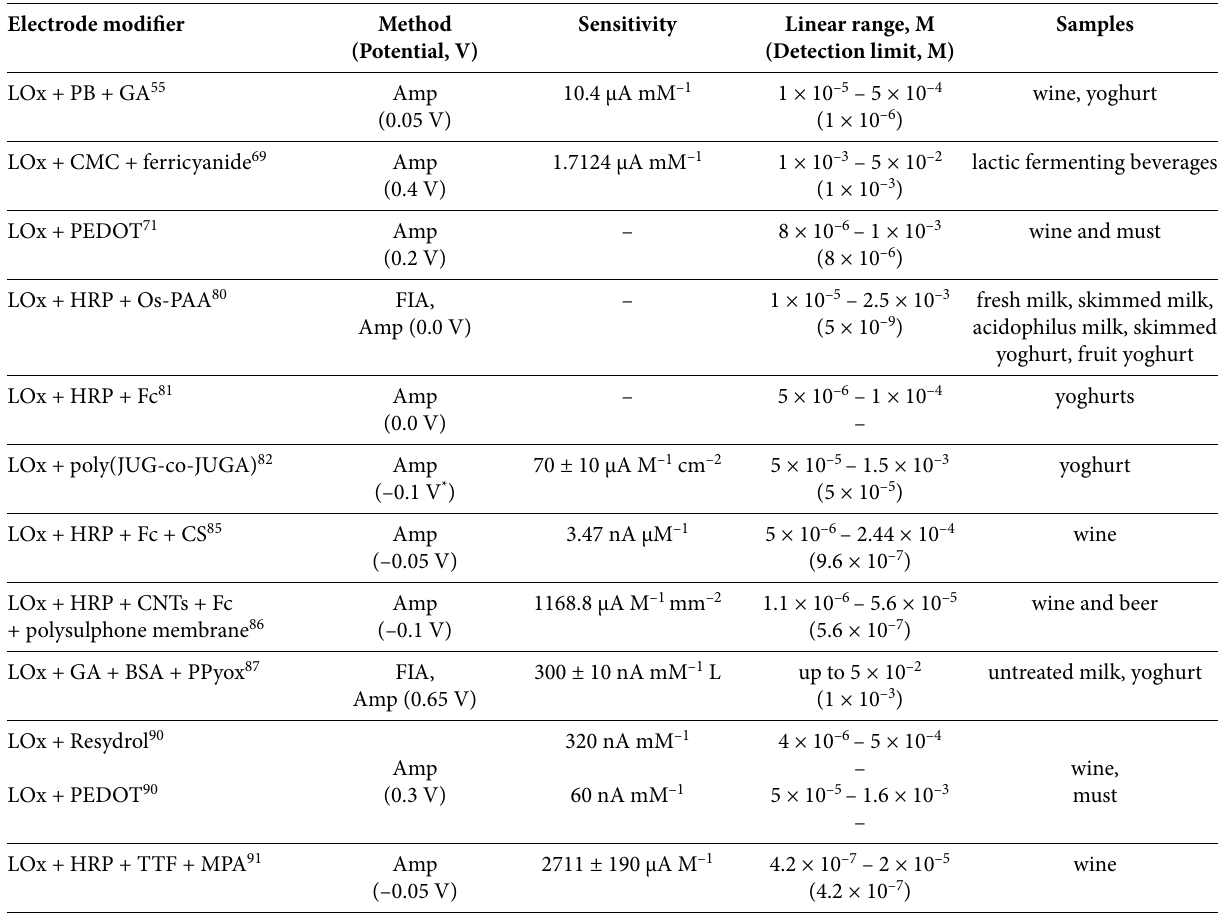
Table 2 . Electrochemical biosensors for lactate analysis in food samples. Electrode